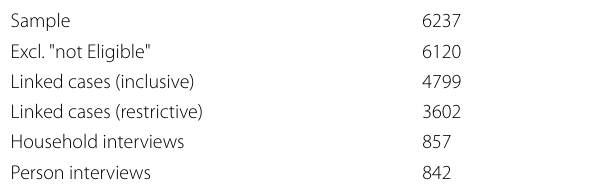
Data: Panel study “Labour Market and Social Security” (PASS), PASS_0618_v1, Sample 6, Waves 5–10 & PASS Paradata, Waves